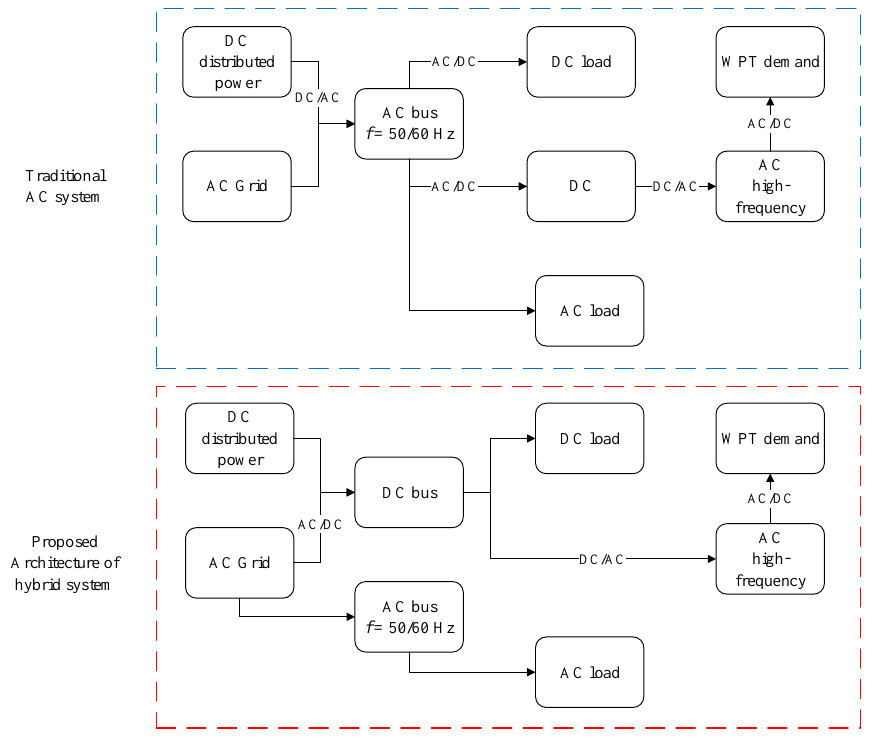
Figure 6. The comparison between traditional AC system and proposed architecture of the hybrid system.